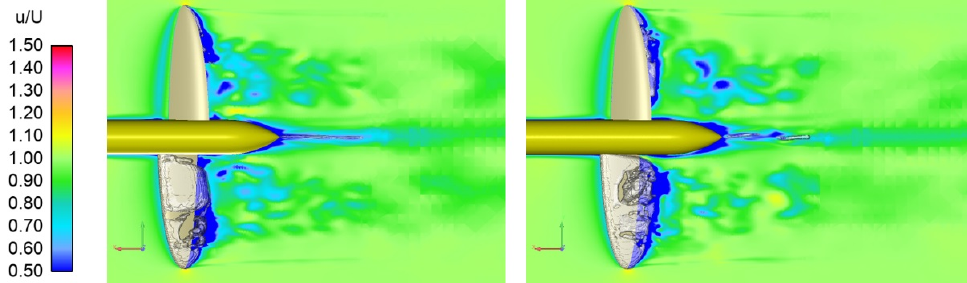
Figure 22. Snapshot of VOF ( left ) and EE ( right ) CFD simulations of u / U ∞ at the mid plane in the vertical direction. Mixture velocity used for the EE solution.